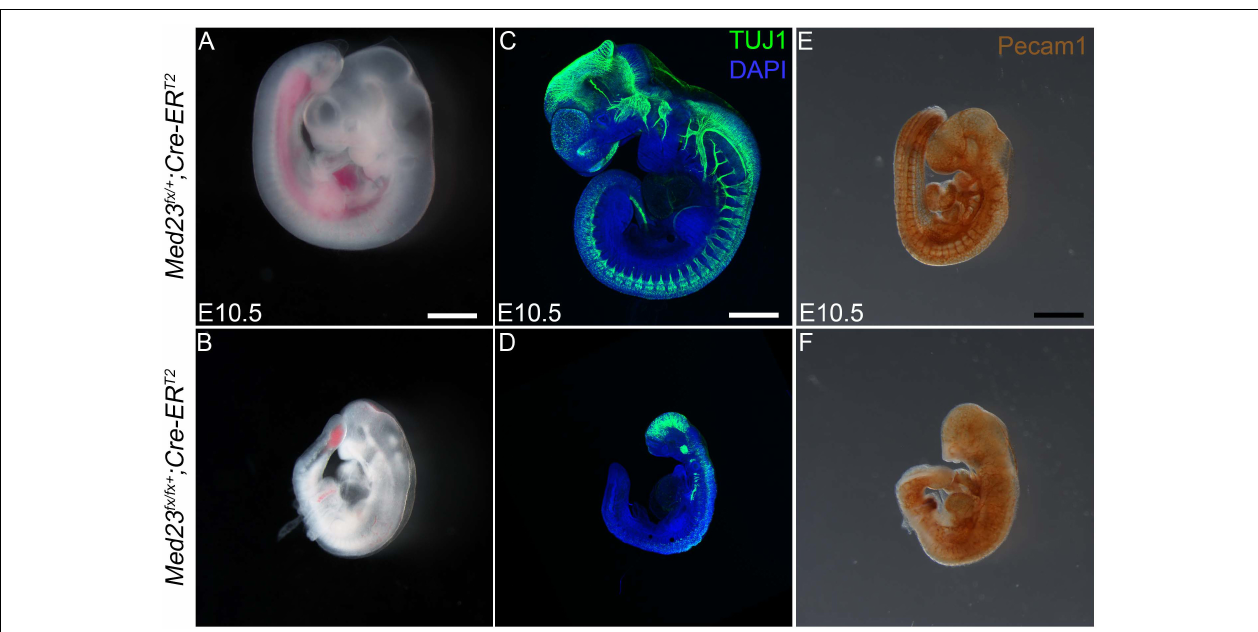
FIGURE 9 | Temporal systemic deletion of Med23 at E6.5 phenocopies Med23 sn / sn embryos. (A,B) Med2 fx / fx ;Cre-ER T2 embryos treated with tamoxifen at E5.5 are small in size compared to Med2 fx / + ;Cre-ER T2 embryos. These embryos also display a shortened frontonasal prominence similar to Med23 sn / sn embryos. (C,D) TuJ1 staining revealed severely hypoplastic cranial as well as vagal ganglia in Med2 fx / fx ;Cre-ER T2 embryos. (E,F) PECAM1 staining revealed that endothelial cells are disorganized in the Med2 fx / fx ;Cre-ER T2 embryos compared to control Med2 fx / + ;Cre-ER T2 embryos. Scale bars for (A,B) is 250 um, (C,D) is 375 um, (E,F) is 300